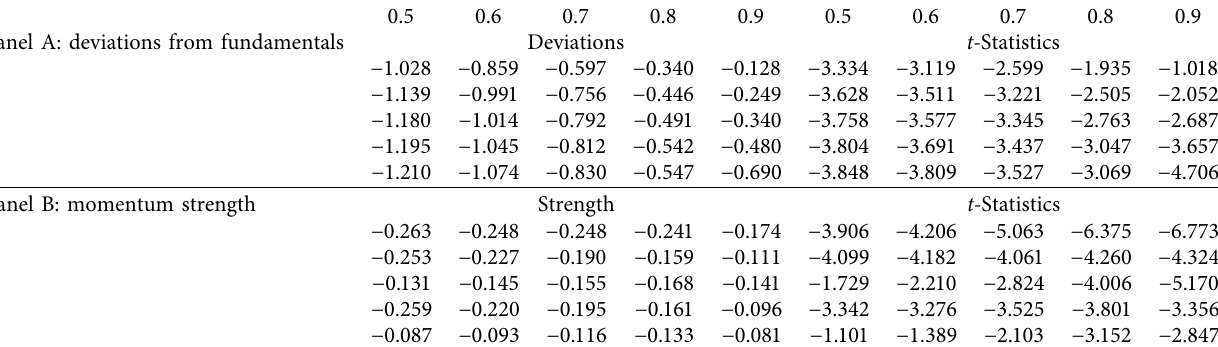
Table 1: Simulations without evolutions. Note: This table reports deviations from fundamentals (differences between the asset price and the fundamental price) and momentum strengths considering various proportions of the anxious agent. The market proportions of the anxious agents lie between 0.5 and 0.9. The indicator of behavioral hesitation (denoted by d ) is between 1 and 5. When d equals 1, the expectation for ) � p + λ × F x price of the anxious agent can be written as E x t ( p j,t + j,t j,t − 1 . Hence, the anxious agent does not embody hesitation since the 1 agent only relies on the single-period forecast error in such a case. However, hesitation begins to emerge if d is 2 or over 2 since the agent refers to multiperiod forecast errors. In Panel A, we calculate the mean and the t -statistic of the mean for deviations from the fundamentals. To be precise, in our statistical inferences, we perform a one-sample t -test in each simulation window. After acquiring the t -statistic for each window, we then compute the average of the t -statistics across windows. Such a procedure used to infer the statistical significance can also be found in Gatti and Grazzini [88] and Garc´ıa-Magariño et al. [89]. As for the momentum strength of the asset, we show the results in